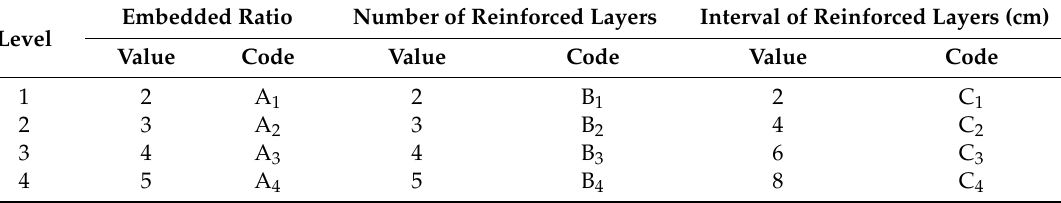
Table 4. Code for three factors at four values.